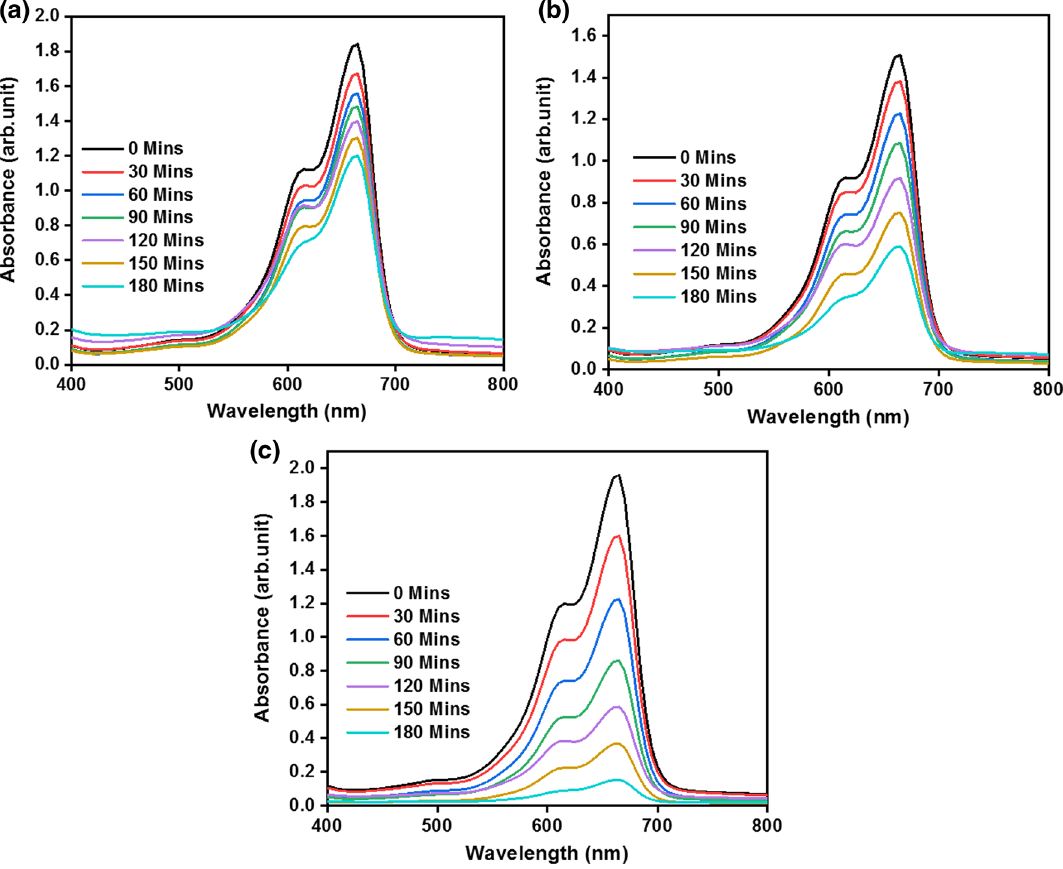
Fig. 7 UV–visible absorption spectra for MB degradation by samples of a SnO